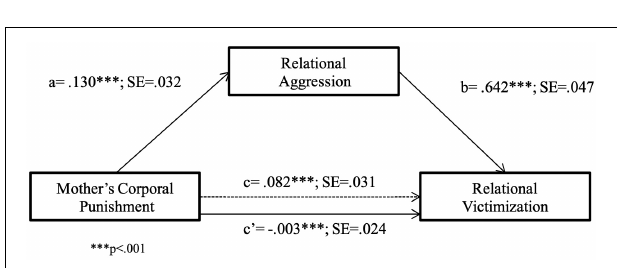
FIGURE 6 | Relational victimization predicted from mother’s corporal punishment through relational aggression. ∗∗∗ p <